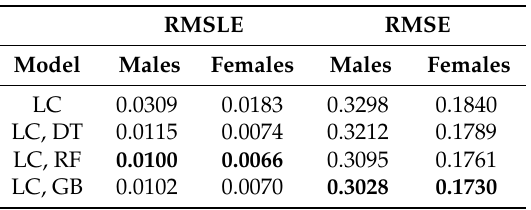
Table 6. Out-of-sample test results: RMSLE and RMSE for the LC model without and with machine learning. Years 2000–2014 (fitting period: 1960–2000). Values in bold indicate the model with the smaller RMSLE and RMSE. RMSLE